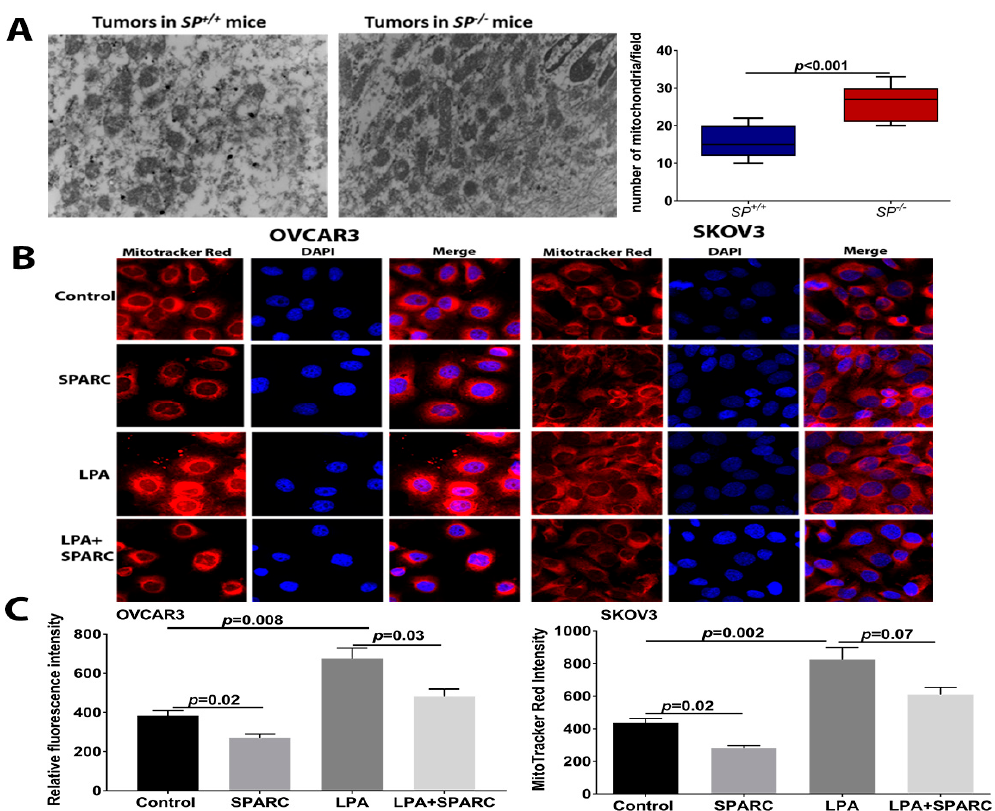
Figure 7. Effect of SPARC on mitochondrial mass: ( A ) Electron microscopic images of the mitochondria in ID8 syngeneic tumors in SP − / − and SP +/+ mice (top). Bars depict the mean ± SEM of the number of mitochondria in five independent fields/section, n = 4/genotype. p < 0.05, Student’s t -test. ( B ) MitoTracker red fluorescent staining of respiring mitochondria in OVCAR3 and SKOV3 treated with LPA in the presence and absence of SPARC. ( C ) Bars depict the relative fluorescent intensity of Mitotracker stain. p < 0.05, Mann-Whitney Test.